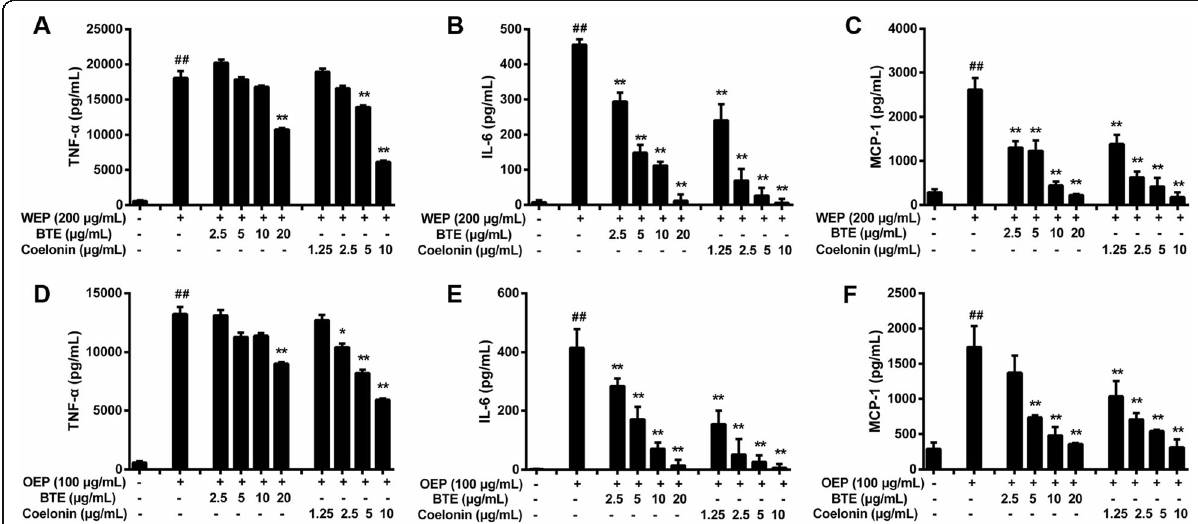
Fig. 3 EFB pretreatment prevented PM 2.5 extracts induced proinflammatory cytokines secretion in RAW264.7 cells. TNF- α ( a ), IL-6 ( b ), and MCP- 1( c ) synthesis in RAW264.7 cells exposed to 200 μ g/mL WEP, which was attenuated by BTE and Coelonin. # < 0.05, ## < 0.01 vs. WEP-only group. TNF- α ( d ), IL-6 ( e ), and MCP-1 ( f ) synthesis in RAW264.7 cells exposed to 100 μ g/mL OEP, which was attenuated by BTE and Coelonin. # < 0.05, ## < 0.01 vs. OEP-only